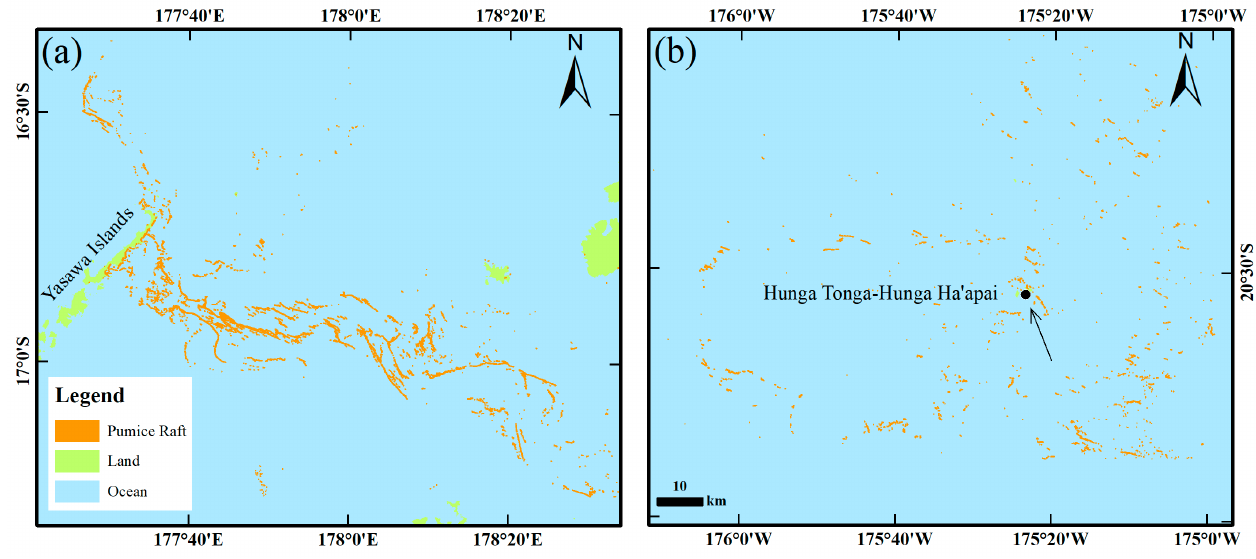
Figure 8. ( a , b ) show the distribution of pumice rafts near the Fiji Yasawa islands in September 2019 and near Hunga Tonga island in January 2022, respectively.